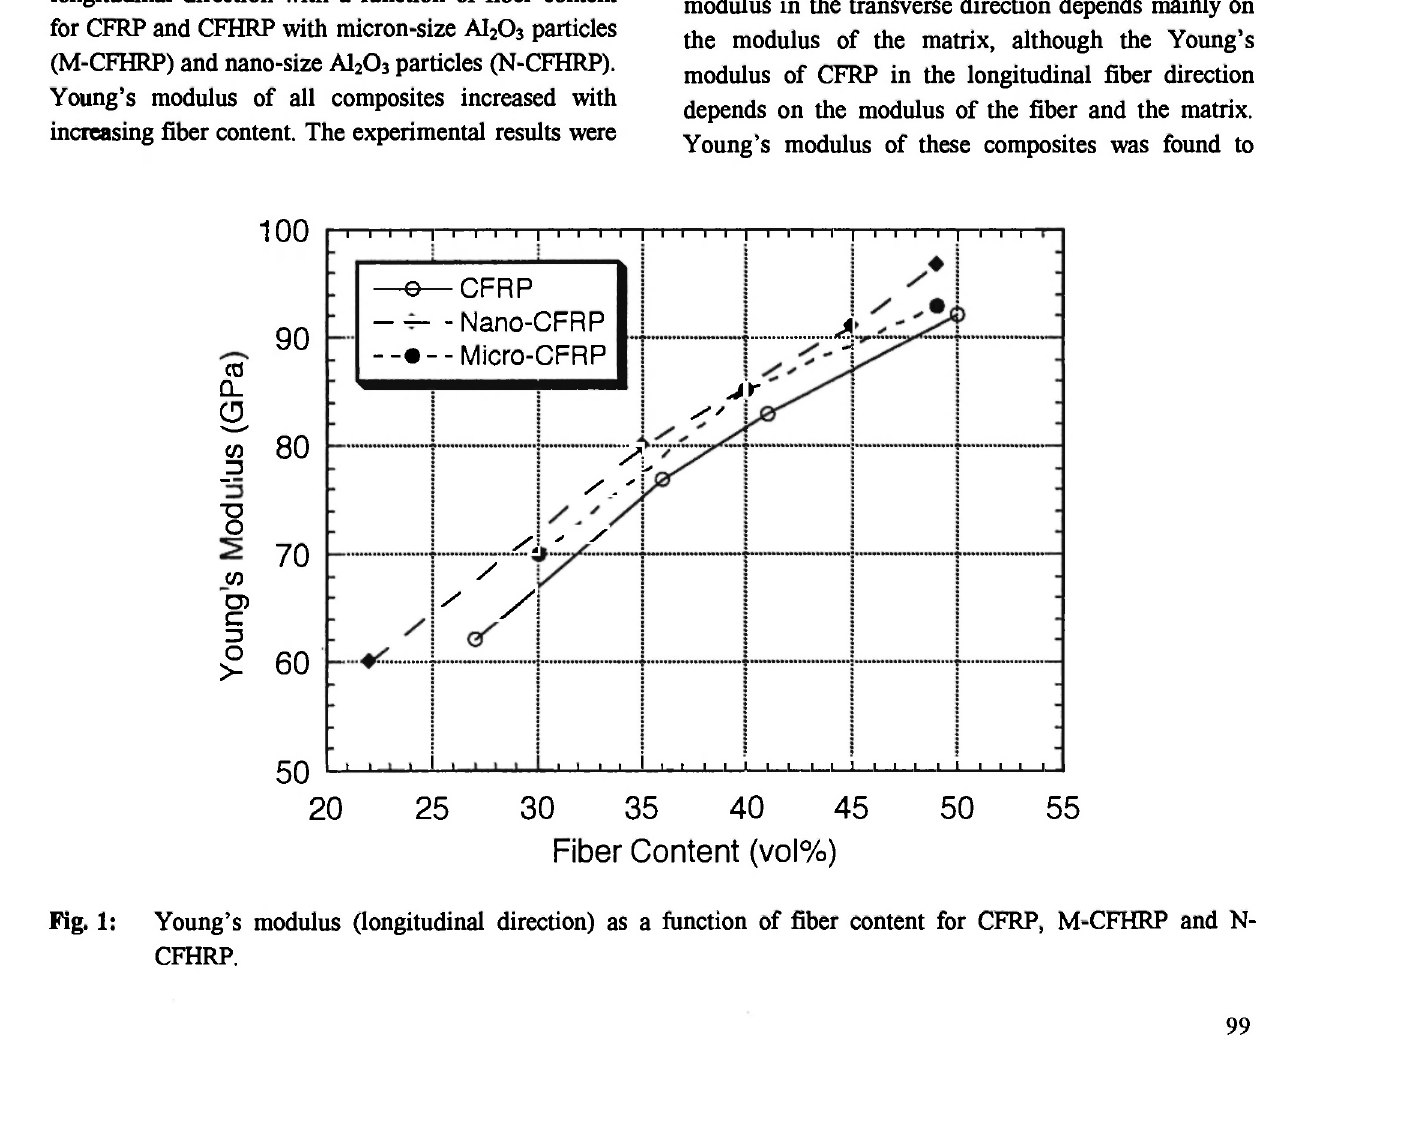
Fig. 1: Young's modulus (longitudinal direction) as a function of fiber content for CFRP, M-CFHRP and N-